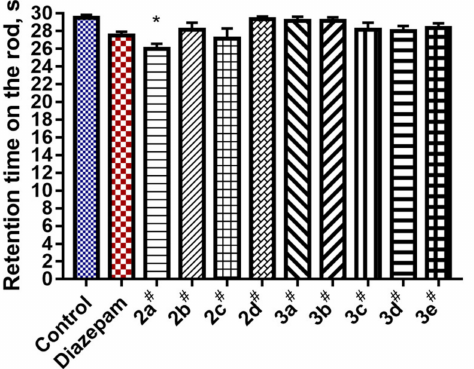
Figure 3. Muscle relaxant activity in compounds 2 and 3 in Rotarod test in comparison with diazepam (2 mg/kg), mice, per oral administration, M ± SEM. Note: * Data are comparable to the control group ( p ≤ 0.05, Kruskal–Wallis test post-hoc Dunn‘s test); # The dose is equimolar to diazepam at a dose of